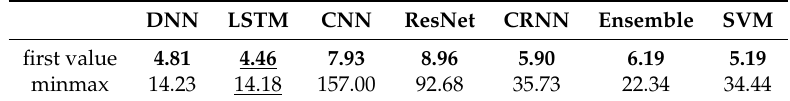
Table 11. Effect of normalization methods on regression (MAPE, %). The sequence size m = 20. The log values of the major features and the sequential partitioning were used.